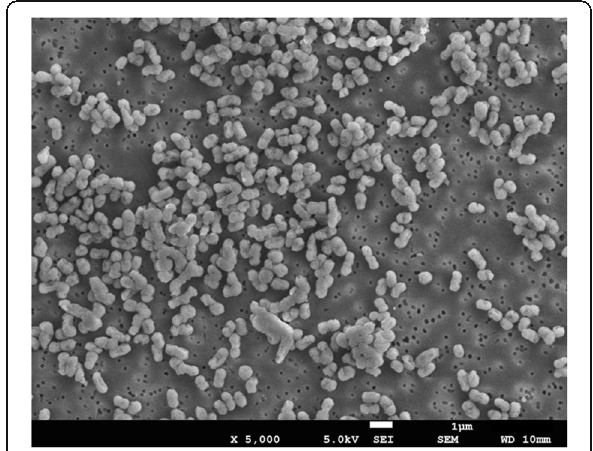
Fig. 2 Scanning electron micrograph of